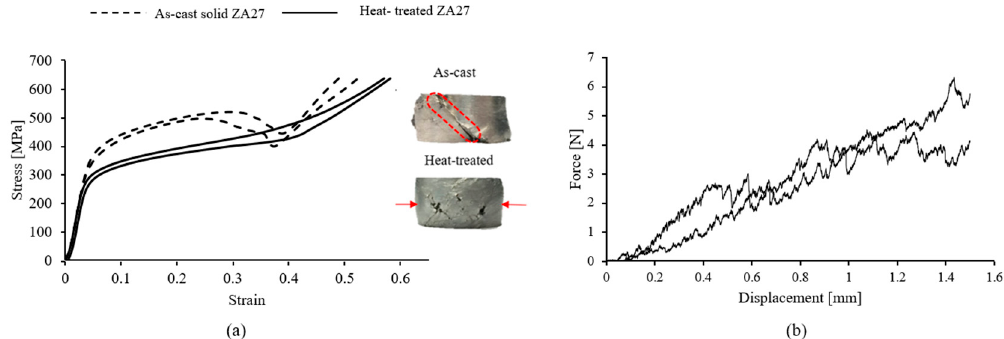
Figure 6. ( a ) Compressive stress-strain curves of as-cast and heat-treated ZA-27 solid samples. ( b ) Compressive force-displacement curves of individual expanded perlite (EP) particles.